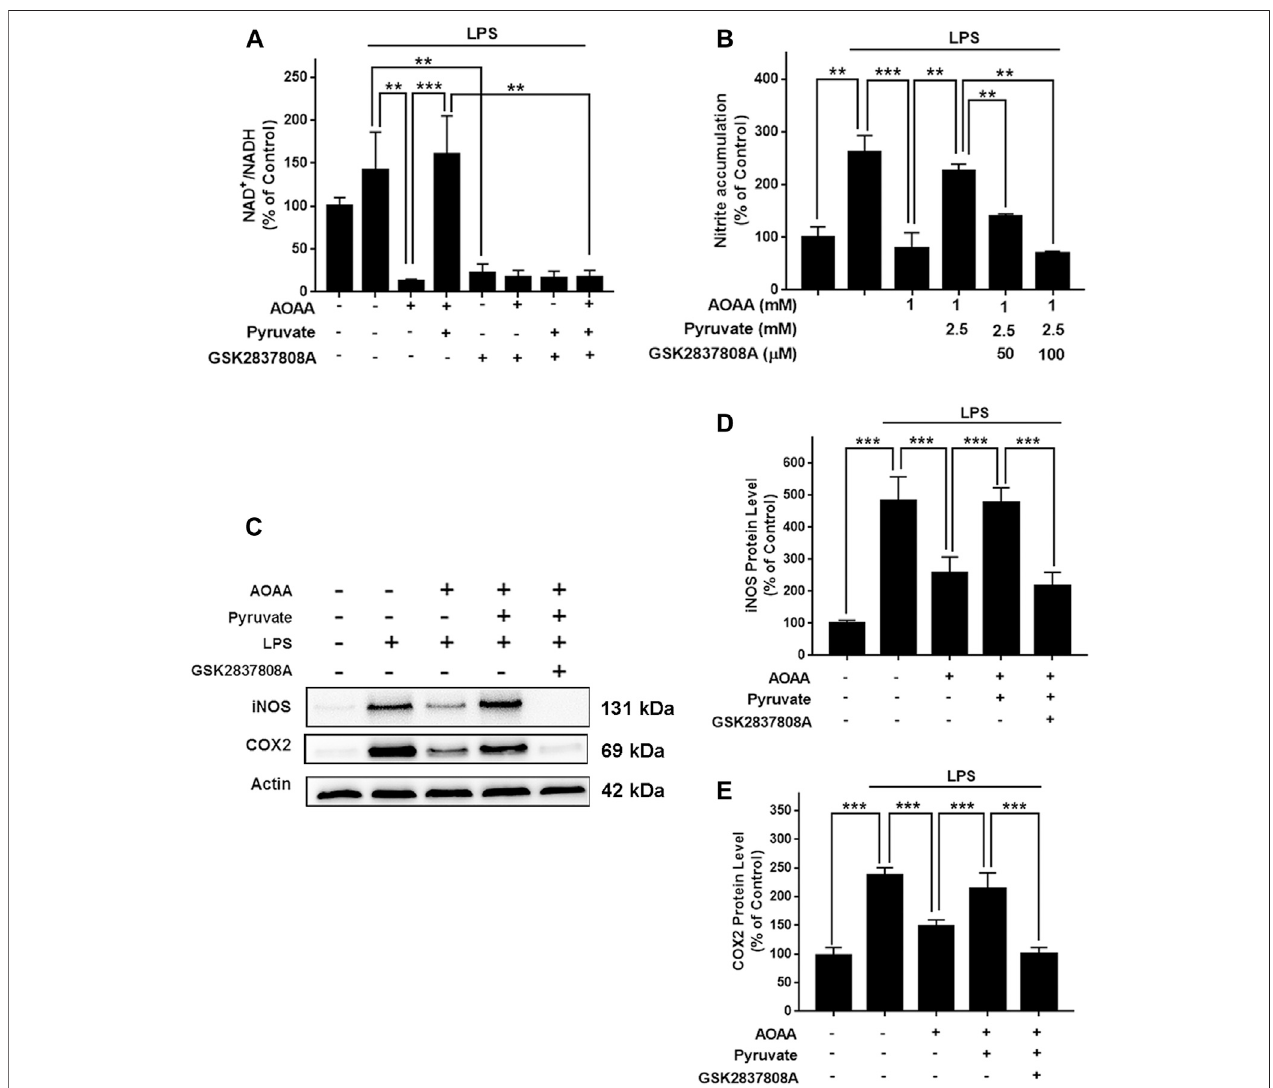
FIGURE 5 | Pyruvate reversed the AOAA-produced decreases in the cytosolic NAD + /NADH ratio and microglial activation of LPS-treated BV2 microglia by promoting LDH-mediated consumption of cytosolic NADH. (A) Treatment of the cells with 100 μ M GSK2837808A completely reversed the effects of pyruvate on the cytosolic NAD + /NADH ratio of the microglial cell cultures treated with LPS and AOAA. (B) Treatment of the cells with 50 and 100 μ M GSK2837808A dose-dependently attenuated the effects of pyruvate on the LPS-induced NO production of the AOAA-treated microglia. (C) Western blot assays showed that treatment of the cells with 100 μ M GSK2837808A reversed the effects of pyruvate on the protein levels of iNOS and COX2. (D) Quanti fi cations of the Western blot assays showed that treatment of the cells with 100 μ M GSK2837808A signi fi cantly attenuated the effects of pyruvate on the protein levels of iNOS. (E) Quanti fi cations of the Western blot assays showed that treatment of the cells with 100 μ M GSK2837808A signi fi cantly attenuated the effects ofpyruvate on the protein levels of COX2. After pre-treatment with 1 mM AOAA for 30 min, the BV2 cells were incubated with 2.5 mM pyruvate, 1 µg/ml LPS, and 50 or 100 µM GSK2837808A for 20 h (for NAD + /NADH assay) or 23.5 h (for NO, iNOS, and COX2 assays). N (cid:2) 3. The data were collected from three independent experiments. **, p < 0.01; ***, p < 0.001.